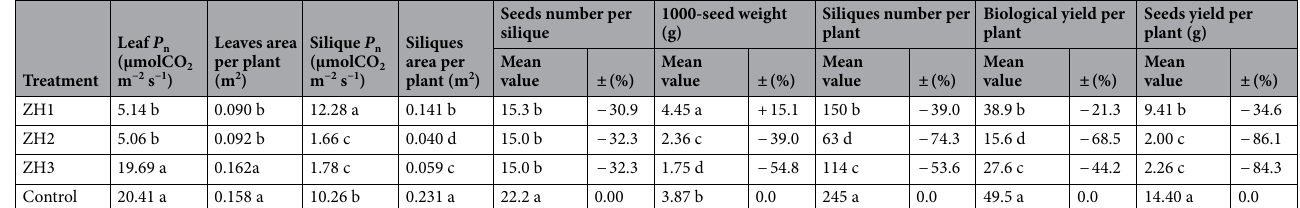
Table 7. Influences of the shading treatments on photosynthetic parameters and yields of rapeseed plant. The ZH1, ZH2 and ZH3 represented treatments that shading rapeseed plant during flowering stage, during time from initial flowering to seed ripening, or during time from flowering ending to seed ripening, respectively; control meant that the rapeseed plant was cultured under natural light condition. The ± (%) represented changerate of mean value of index under shading treatment relative to the Control. The same below.